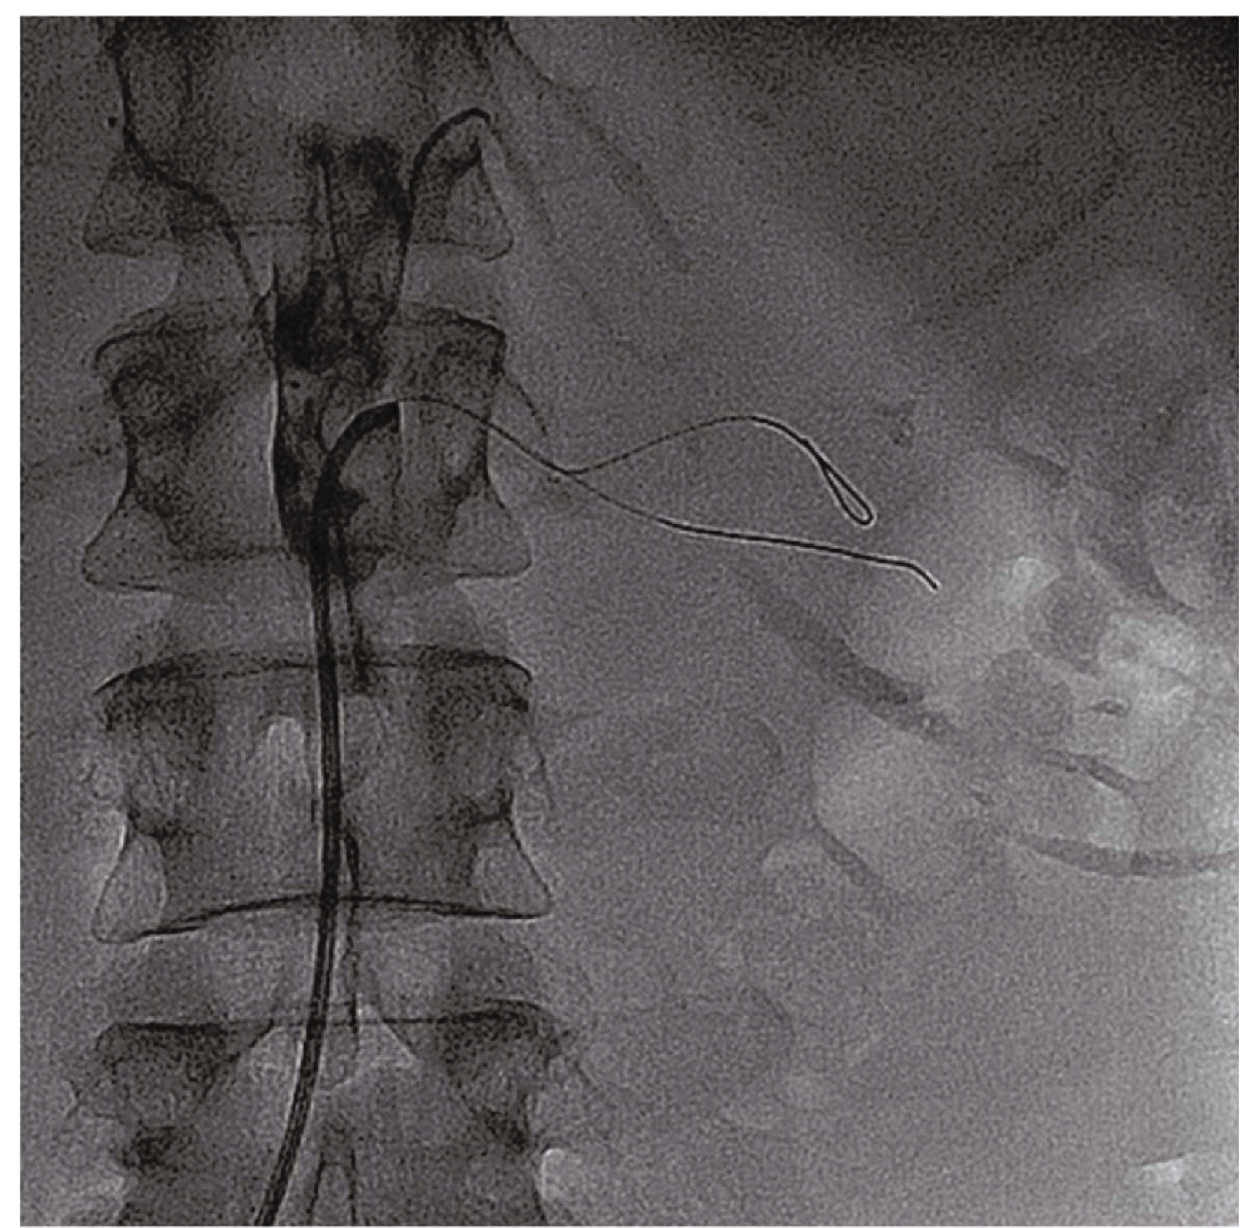
Figure 3: 0.014-inch wire across the occlusion still showing no renal blush and no distal arterial vasculature. Second wire placed in the renal artery due to di ffi culty in advancing the thrombectomy catheter into multiple distal renal artery branches to restore perfusion to multiple renal